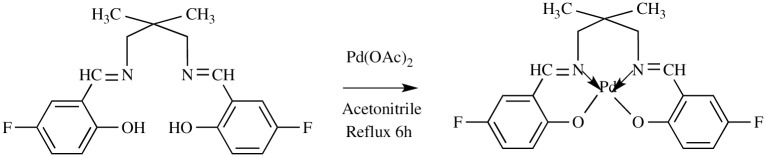
Synthesis of PdL2F.